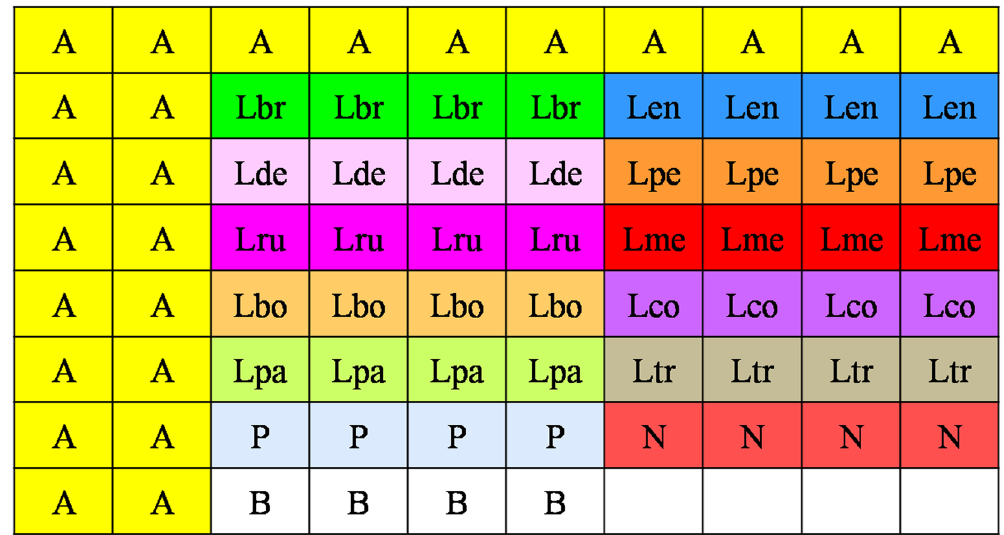
Figure 1. Layout of gene chip probes for 10 species of Liposcelis . The abbreviations and different colors in the table represent different kinds of probes. A: Anchor point probe; P: Positive control probe; N: Negative control probe; B: Blank control; Lbr: Probe for Liposcelis. brunnea ; Len: Probe for L. entomophila ; Lde: Probe for L. decolor ; Lpe: Probe for L . pearmani ; Lru: Probe for L . rufa ; Lme: Probe for L . mendax ; Lbo: Probe for L . bostrychophila ; Lco: Probe for L . corrodens ; Lpa: Probe for L . paeta ; Ltr: Probe for L . tricolor